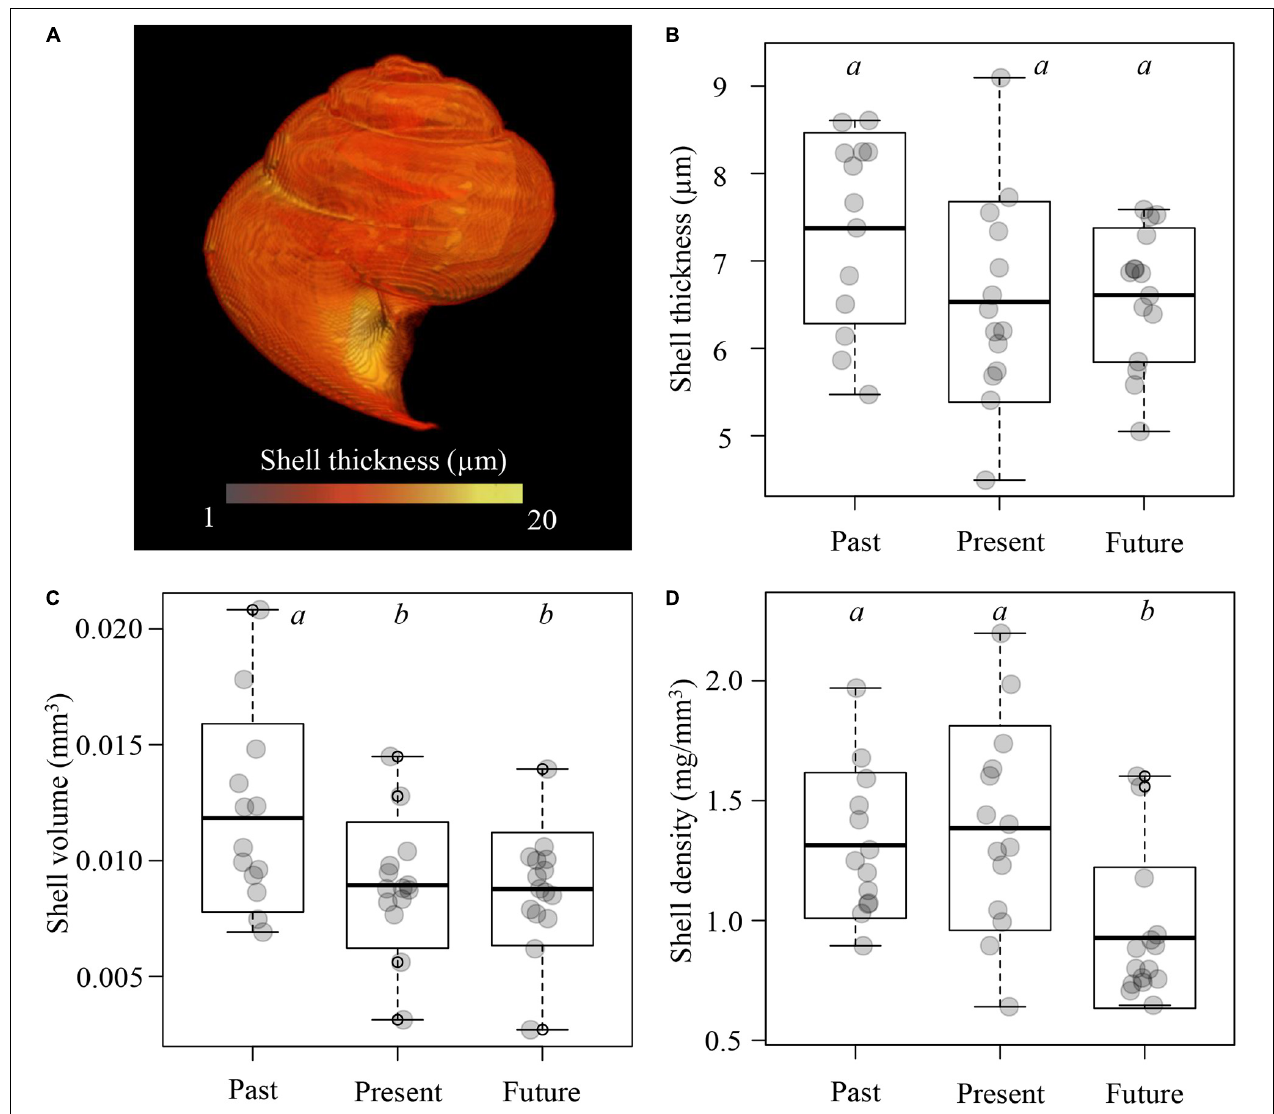
FIGURE 6 | Shell measurements of Limacina retroversa (13–15 individuals per treatment) after exposure to past, present, and near-future conditions. (A) Shell thickness of a representative MicroCT-scanned shell. (B) Shell thickness. (C) Shell volume. (D) Shell density. Boxplots with different letters denote significant differences between treatments (see main text for